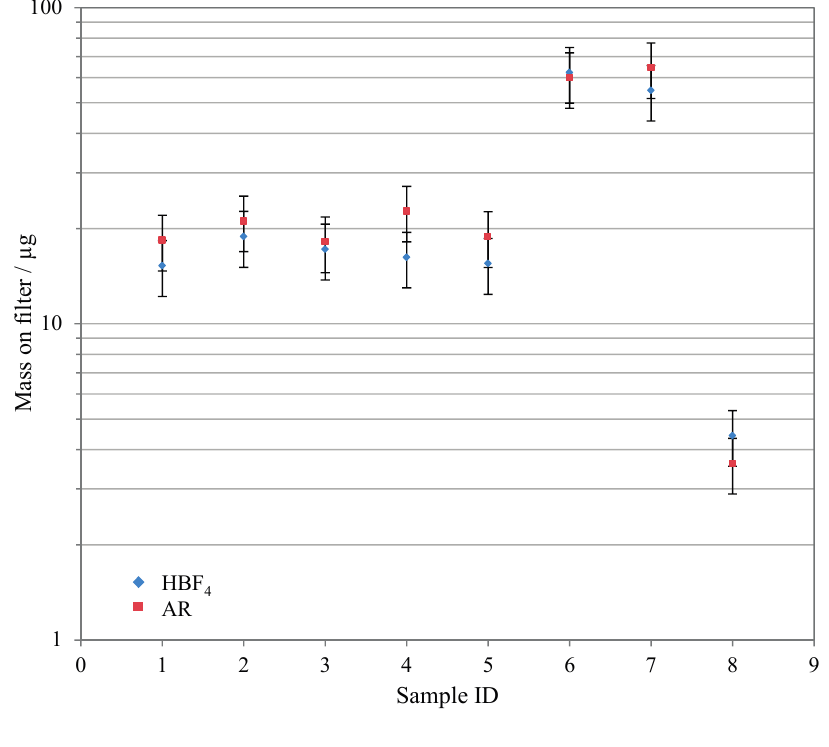
Figure 6. Comparison of the mass of Pb observed on quartz filters using the HBF 4 /HNO 3 and AR extraction techniques, error bars set to